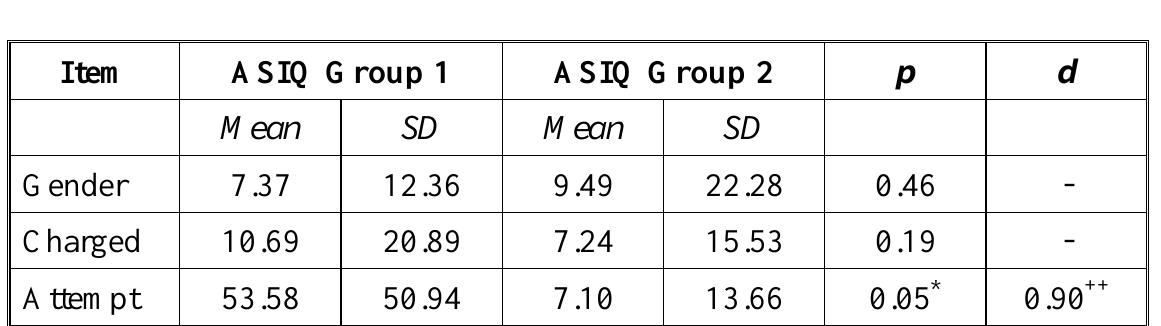
Differences between the suicide ideation of different demographic groups